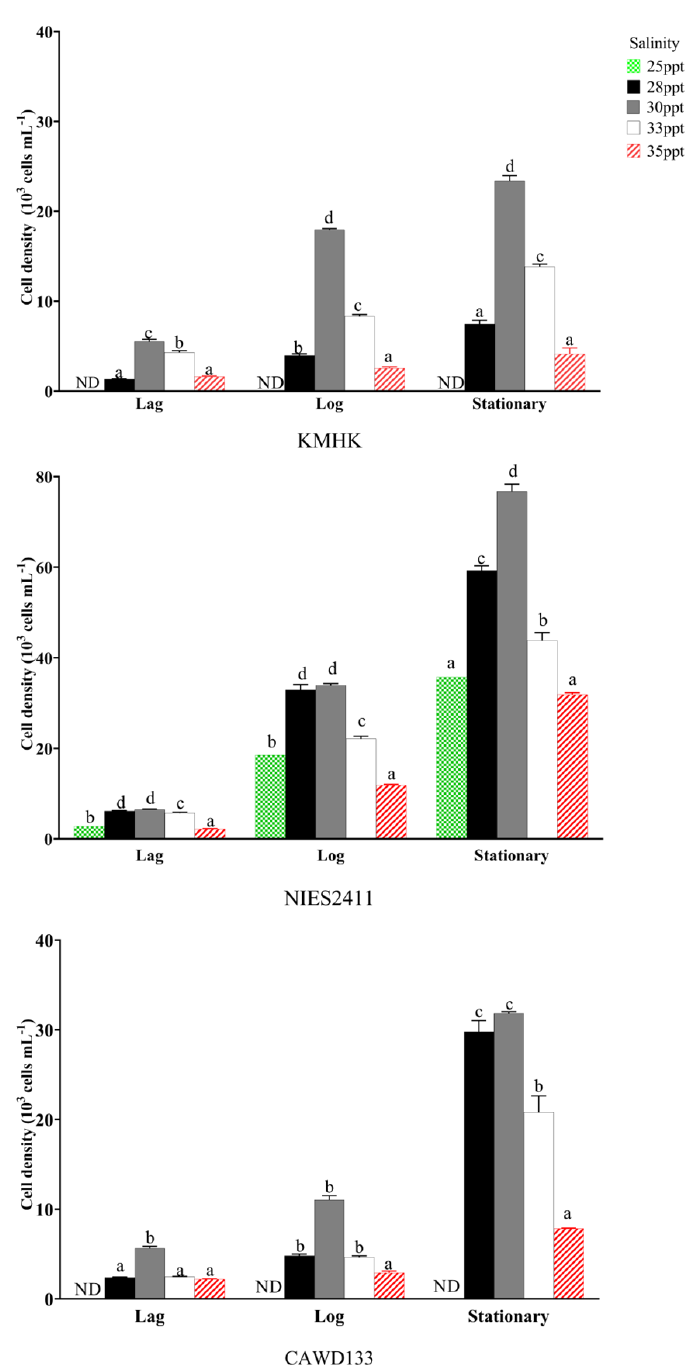
Figure 6. Growth of the three K. mikimotoi strains (KMHK, NIES2411 and CAWD133) in different salinities (25 to 35 ppt) and growth phases (lag, log and stationary phase). The initial algal cell density of K. mikimotoi was 4 × 10 4 cells mL −1 and the corresponding days for harvesting the algal cells of each strain at different growth phases were listed in Table A2. Non-toxic algal species Dunaliella tertiolecta (STK − 2) was used as control and no mortality of the gill cells was observed within the 120 min exposure. Small letters indicate a significant difference in cell density at different salinities within a growth phase. Each bar represents the mean ± standard error of mean (SEM) of three true replicates. ND: not